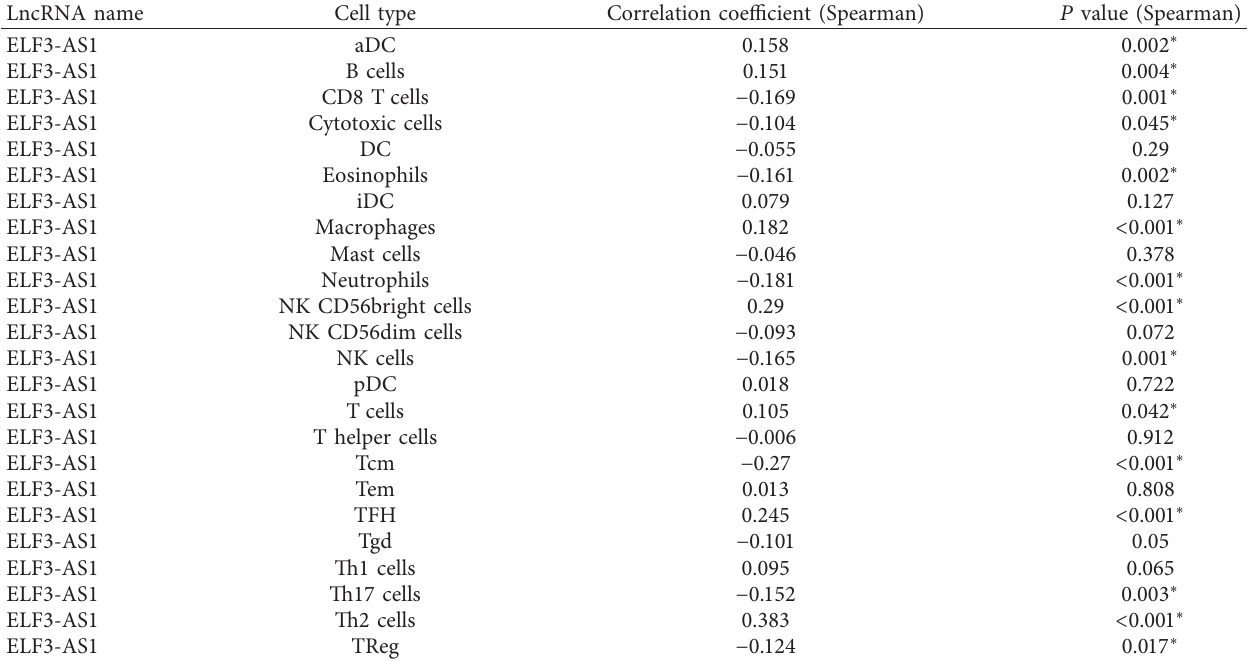
Table 6: Correlation between ELF3-AS1 expression in HCC and immune